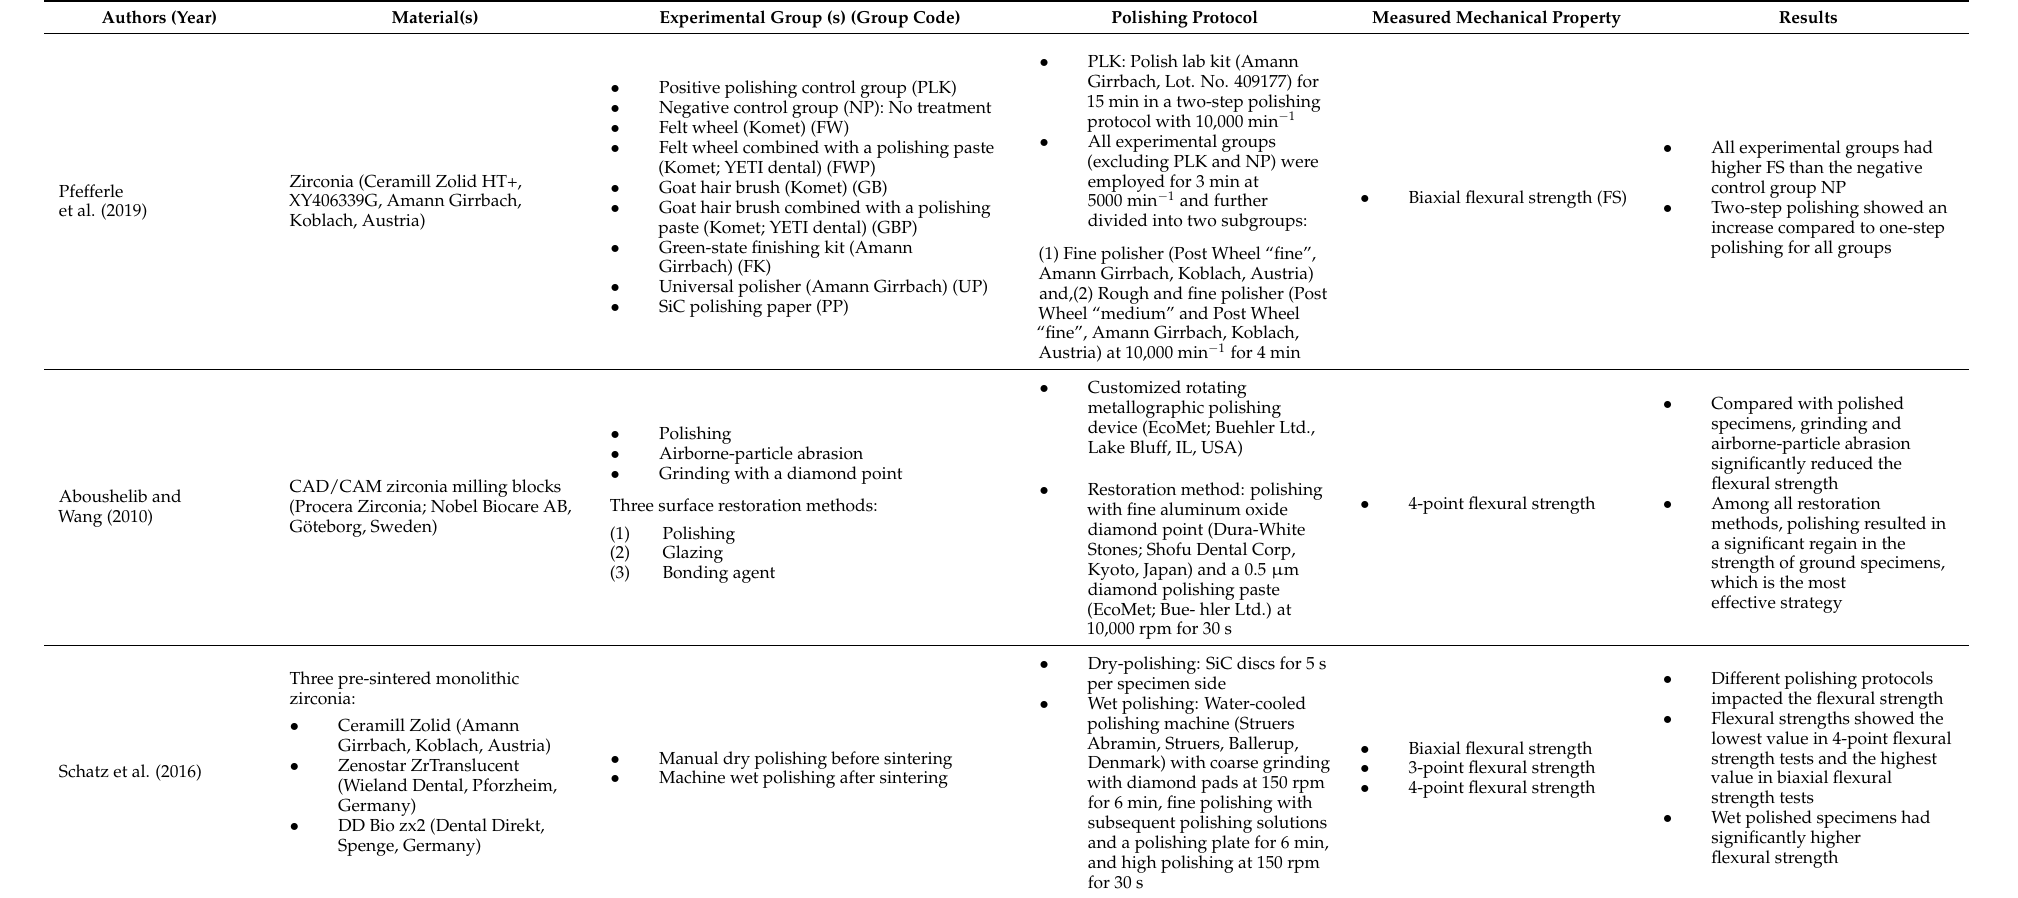
Table 3. Summary of the polishing protocol and mechanical properties measurement in the included